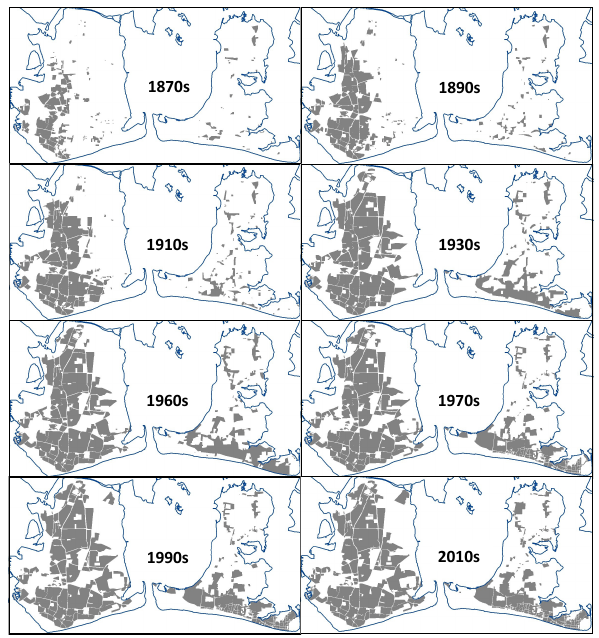
Figure 5. Digitised residential areas in Portsea Island (left is- land) and Hayling Island (right island). Maps sourced from Digimap ® Crown Copyright and Landmark Information Group Limited (2014). All rights reserved. (See Appendix A for compre- hensive list of maps